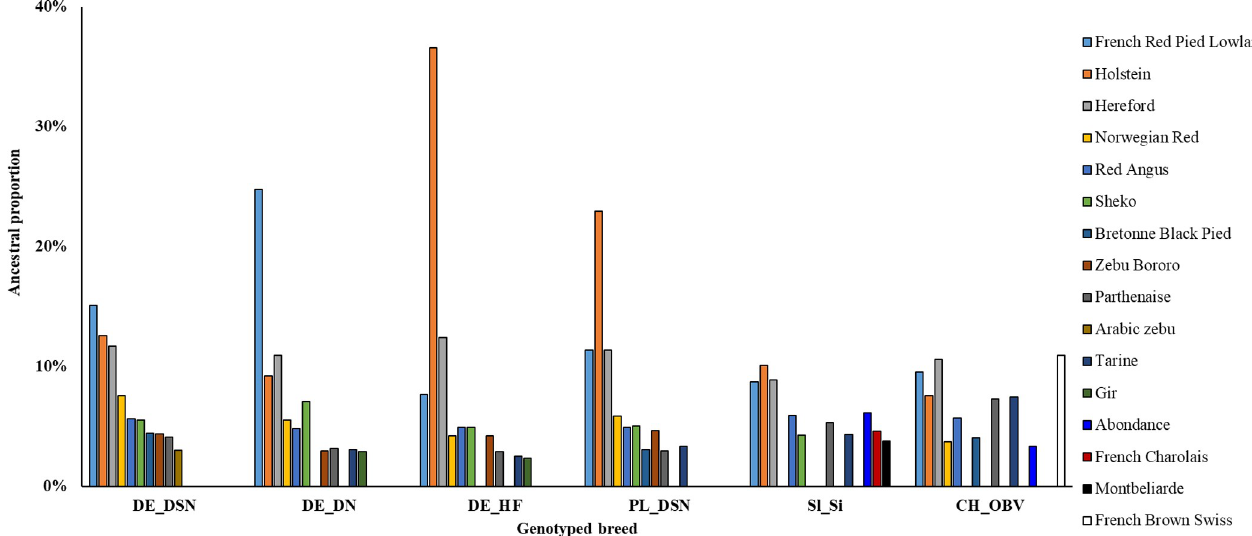
Fig 2. Ancestry composition of the genotyped cows considering the ten reference populations in WIDDE [16]. DE_DSN = black and white dual-purpose (Germany); DE_DN = red and white dual-purpose (Germany); DE_HF = Holstein Friesian (Germany); PL_DSN = black and white dual-purpose (Poland); Sl_Si = Simmental (Slovenia); CH_OBV = dual-purpose Original Braunvieh (Switzerland).